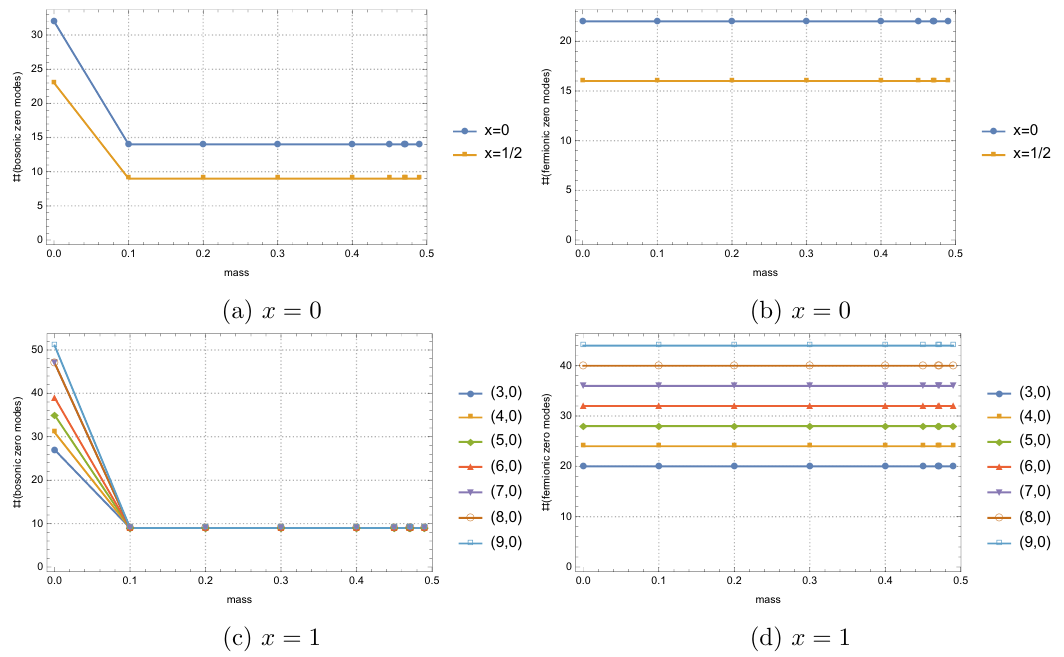
Figure 27. C [( N; 0)] + D with Higgs con(cid:12)guration (B.9). We provide the number of zero modes of O X + (cid:30)